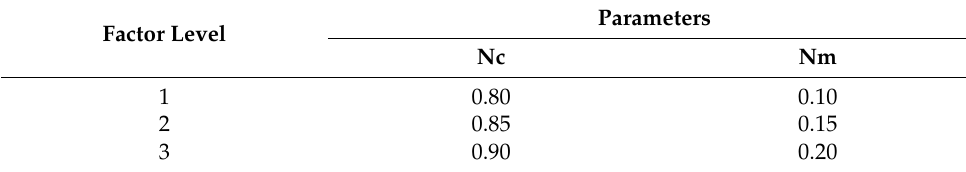
Table 4. Factor level of parameters.